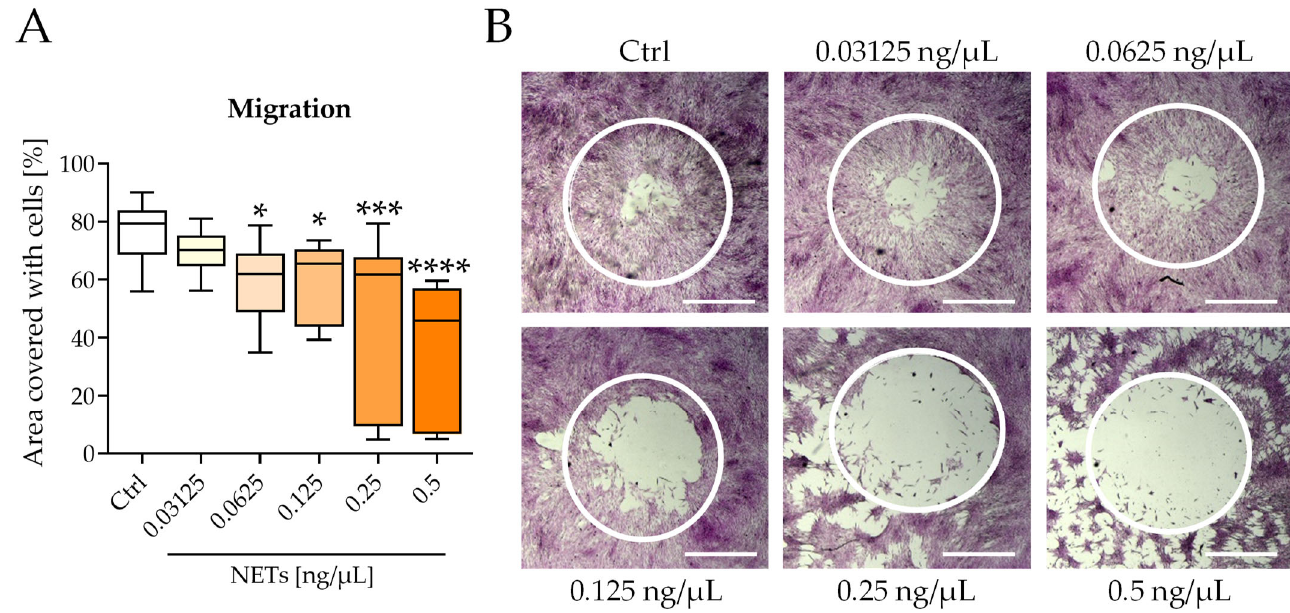
Figure 2. NETs impaired the migration of SCP-1 cells. The migration of SCP-1 cells was analyzed after 45 h of incubation with NETs. ( A ) Migration to a cell-free area. ( B ) Exemplary images of migration of SCP-1 cells after 45 h. Cells were stained with SRB. White circles highlight the cell-free area at time point 0 h. Original magnification 2×, scale bar 1000 µm. N = 3, n = 3. * p < 0.05, *** p < 0.001, **** p < 0.0001, as determined by the Kruskal–Wallis test.